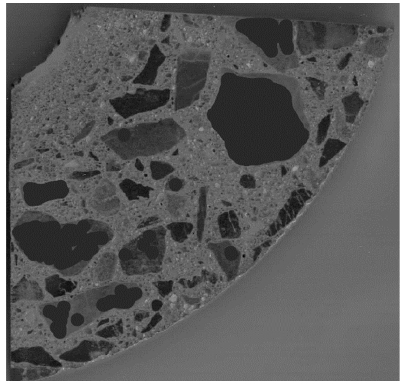
Figure 7. Mask created from green channel (G).